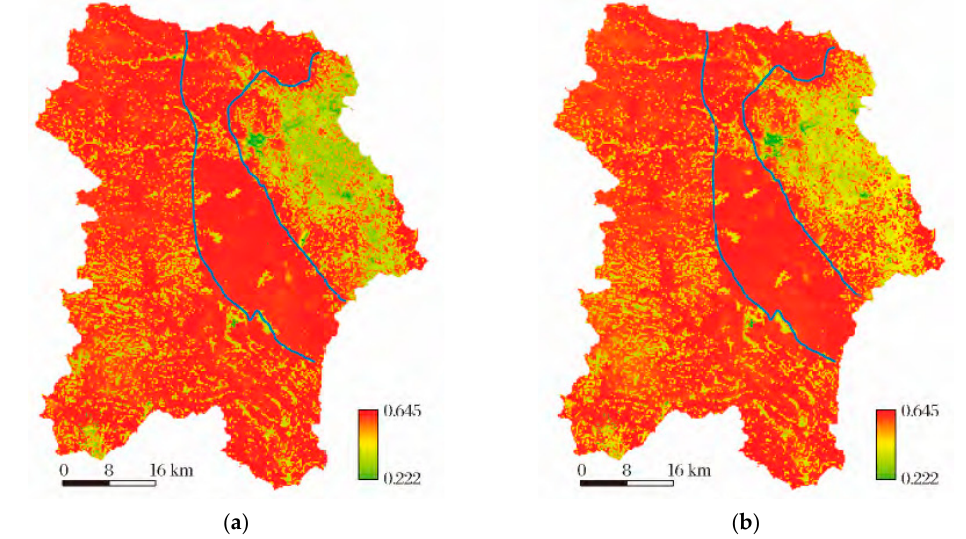
Figure 4. Results of biodiversity comprehensive assessment in Nanzhang County of Hubei Province, China in the year of 2010 ( a ) and 2010 ( b ) [63].